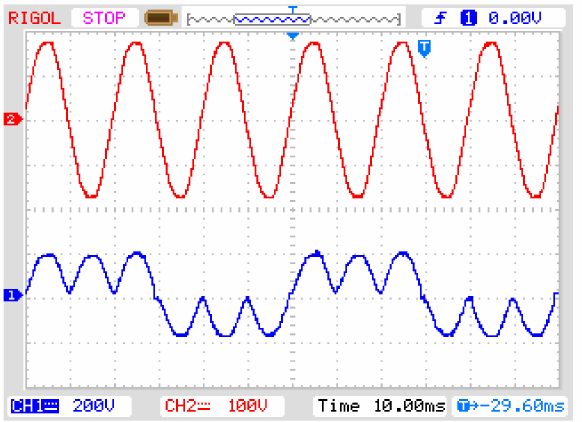
Figure 12. Real value results for output frequency step-down process with a voltage gain of